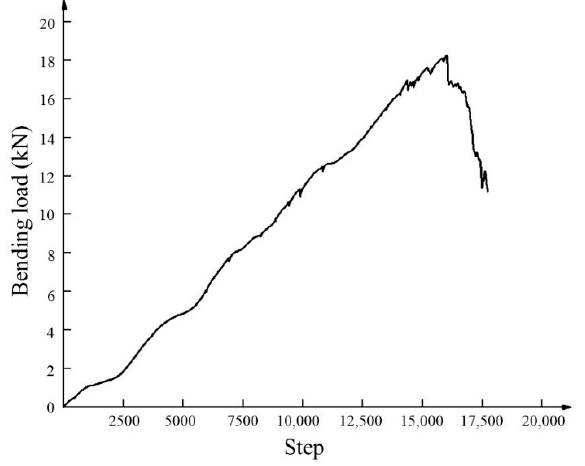
Figure 14. Stress curve of the panel samples. Bending load refer to a load that causes bending deformation of a panel during a fixed strength test.